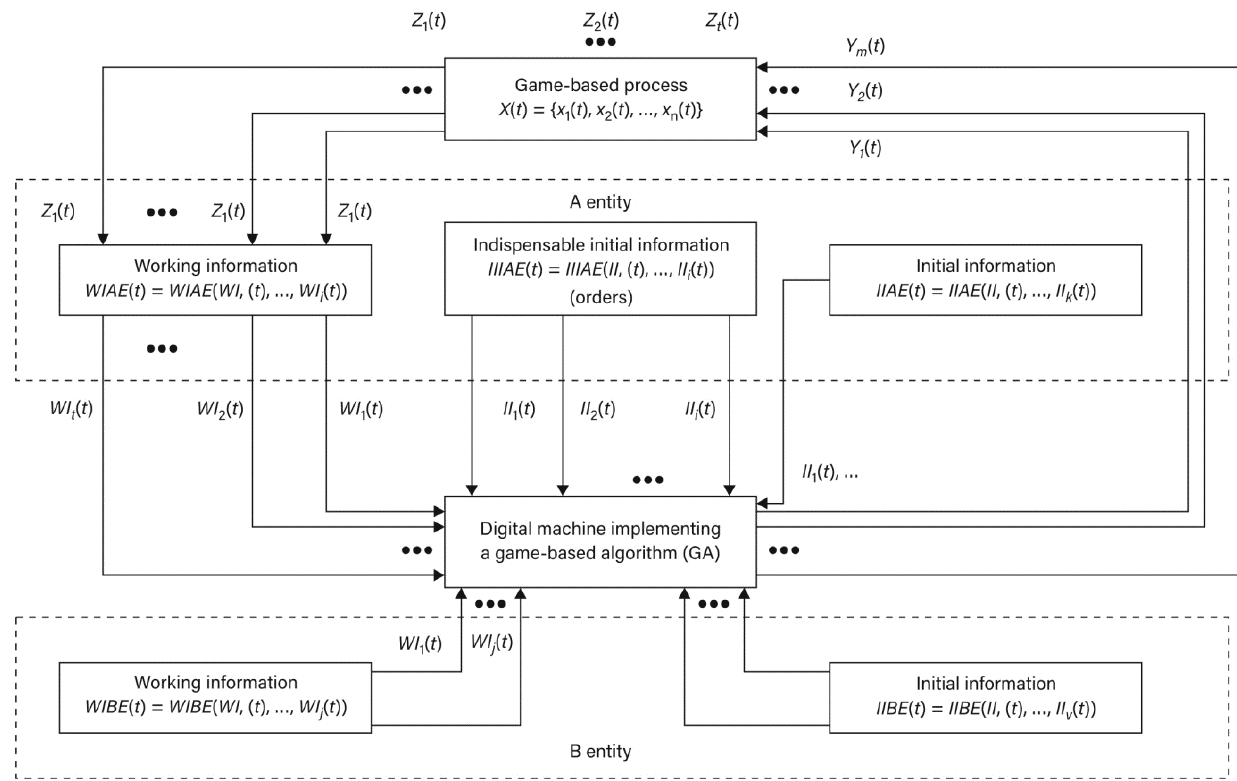
Figure 1. Information model of a game-based system (GS) [33].